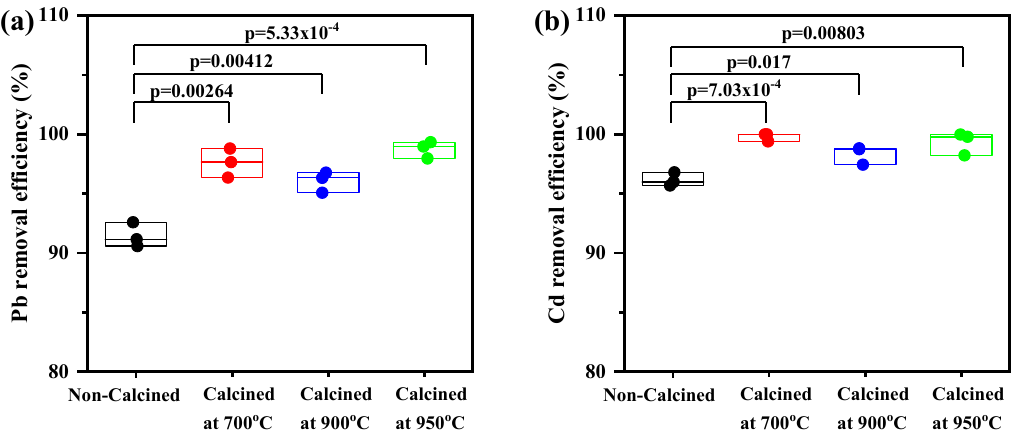
Figure 7. Box–whisker plots presented for the heavy metal removal efficiency (%) of uncalcined and calcined CS at 700, 900, and 950 ◦ C: ( a ) Pb and ( b ) Cd. All values are shown with boxes representing the 25th and 75th percentiles of data. Whiskers represent the 5th and 95th percentiles of data.